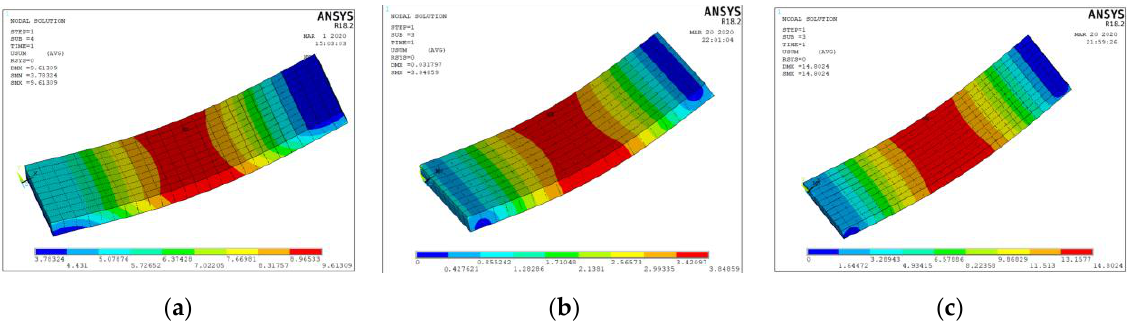
Figure 23. Deflection nephogram of composite floor with different span: ( a ) 2500, ( b ) 2000 and ( c ) 3000 mm.